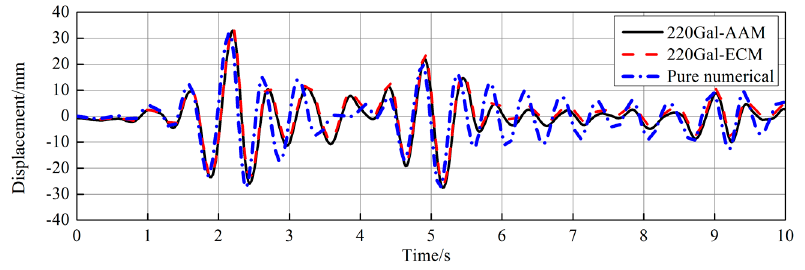
Figure 10. Horizontal displacement on the top of experimental column (220 Gal).